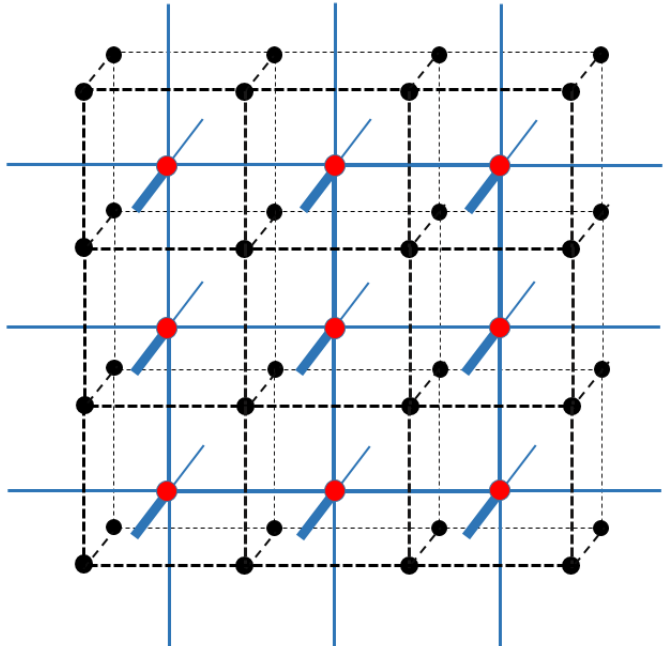
Figure 2 . A boundary face in the three dimensional case. Wilson loops that lie in the magnetic centre are shown as dashed lines on the boundary face. Their duals are electric link operators along the outward directed normals, shown as blue links emanating from the vertices of the dual lattice denoted in